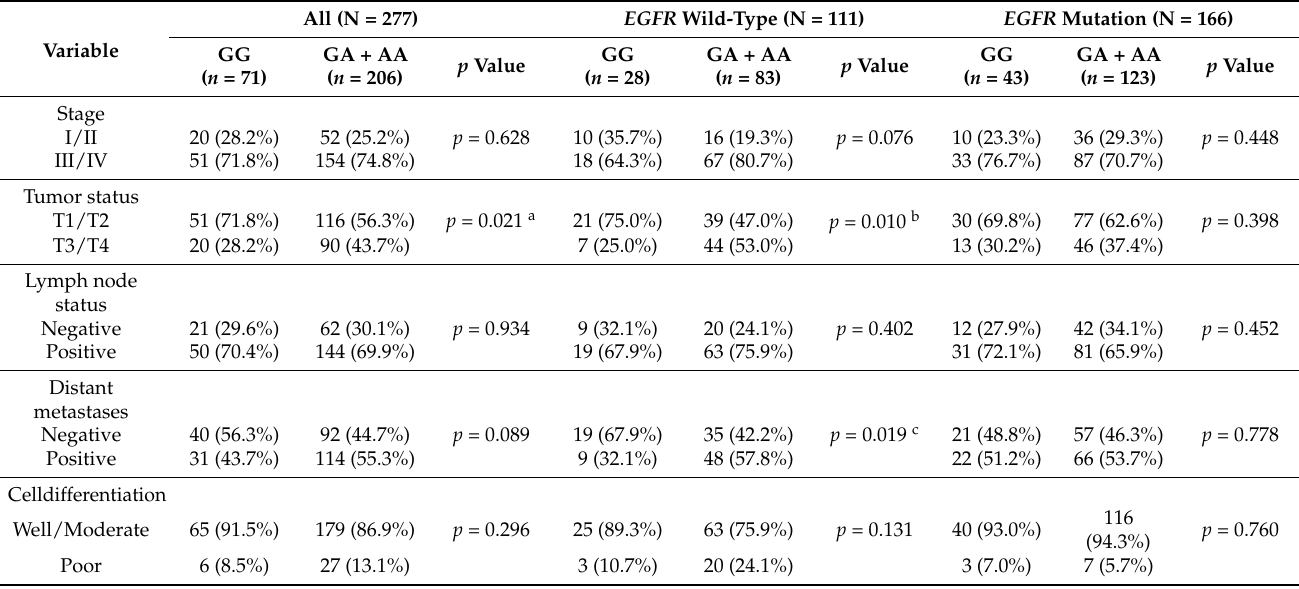
Table 5. Clinicopathologic characteristics of lung adenocarcinoma patients stratified by EGFR status and genotypes at visfatin